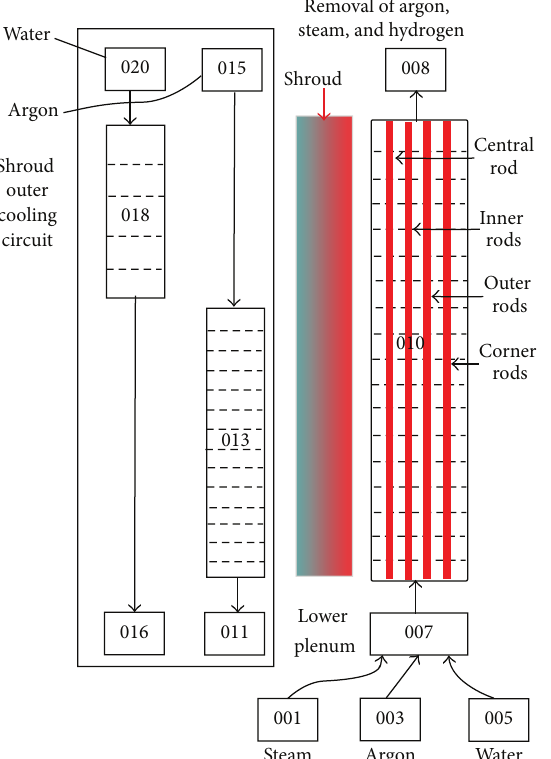
Figure 5: Nodalization scheme of QUENCH test, developed using RELAP/SCDAPSIM computer